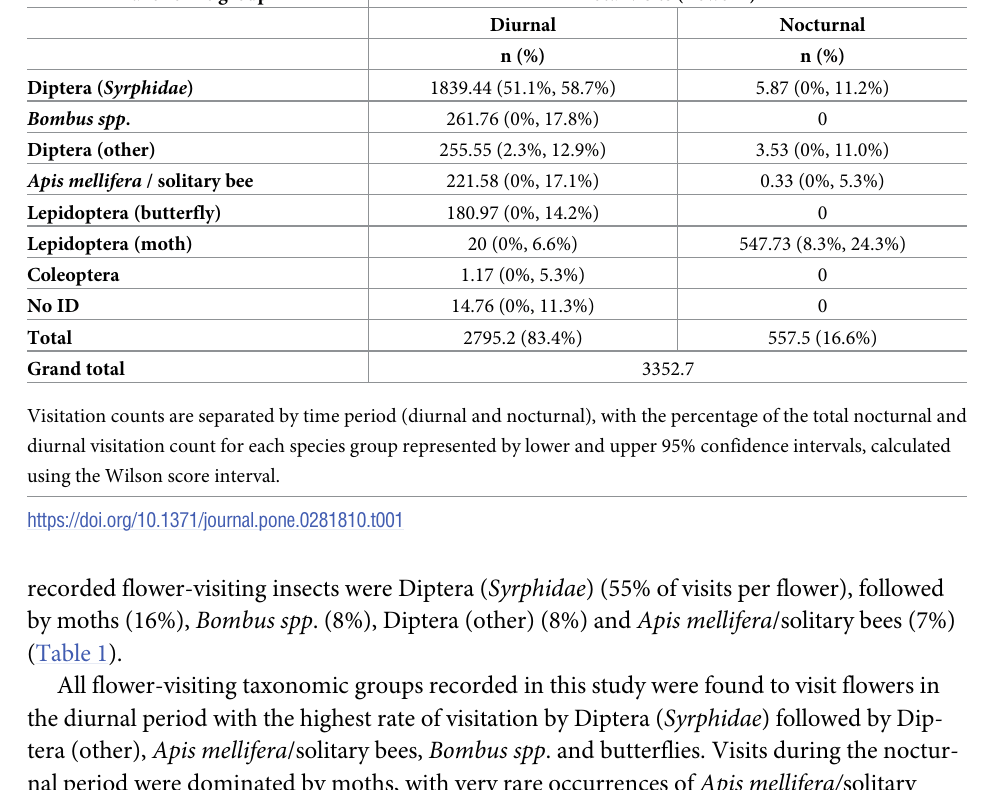
bees, Diptera ( Syrphidae ) and Diptera (other) (Fig 1).